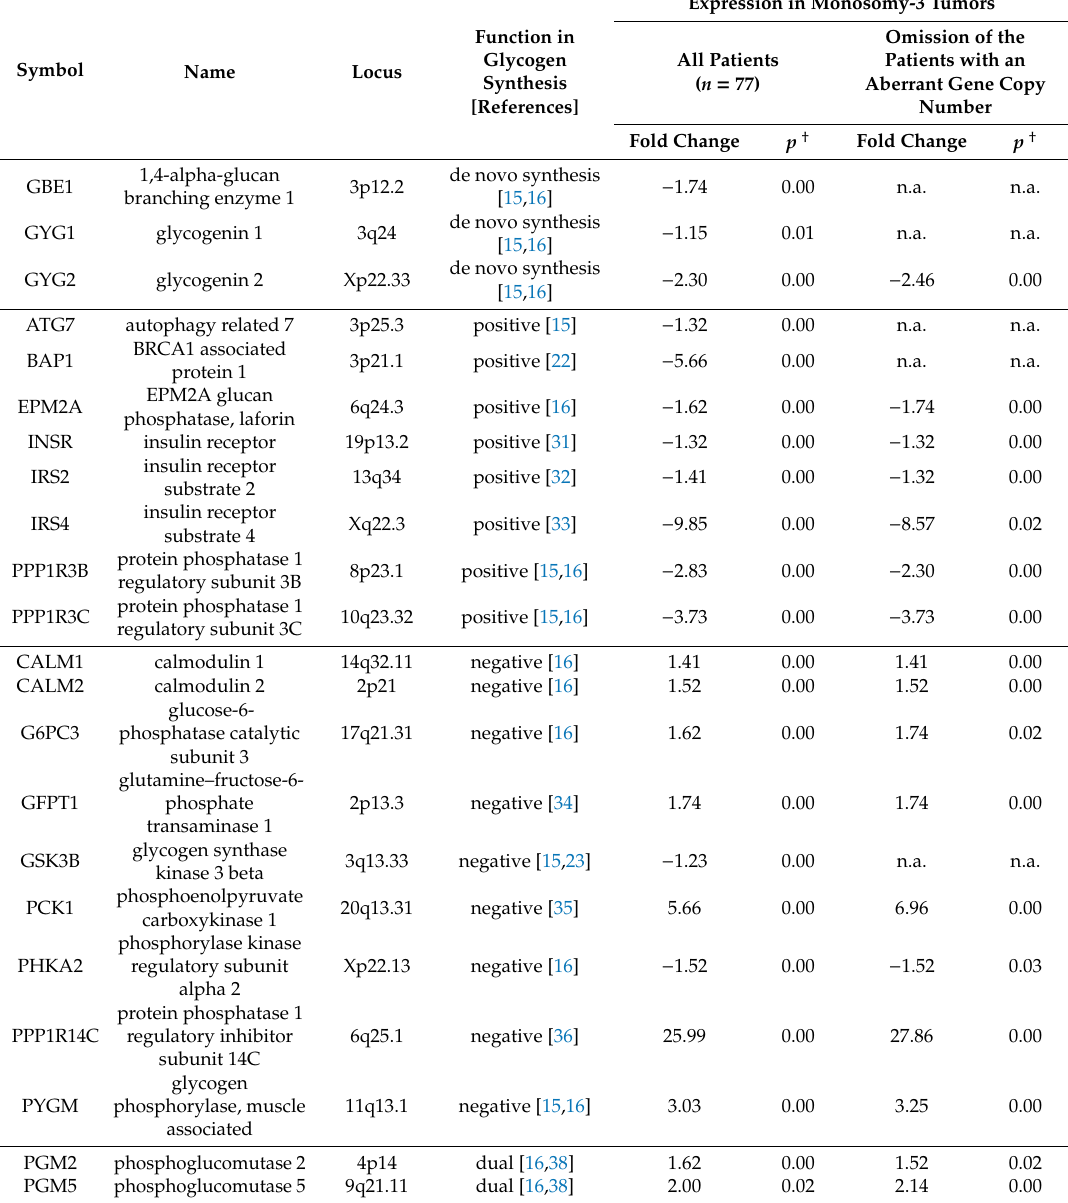
Table 1. Human genes involved in glycogen synthesis or breakdown that are di ff erentially expressed in the monosomy-3 tumors of the uveal melanoma (UM) cohort of the Cancer Genome Atlas (TCGA) study.